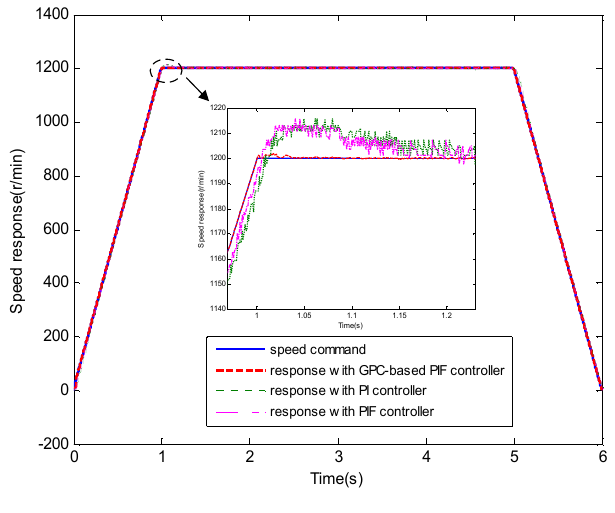
Figure 10. Speed response (test